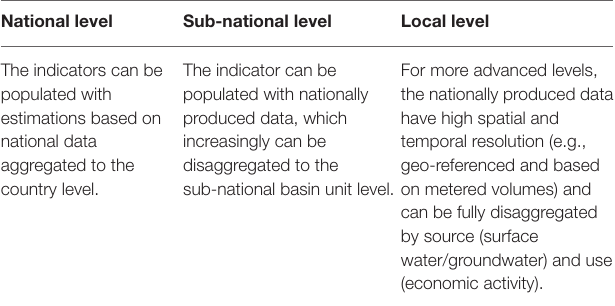
TABLE 2 | Monitoring of SDG implementations at different levels, according to FAO